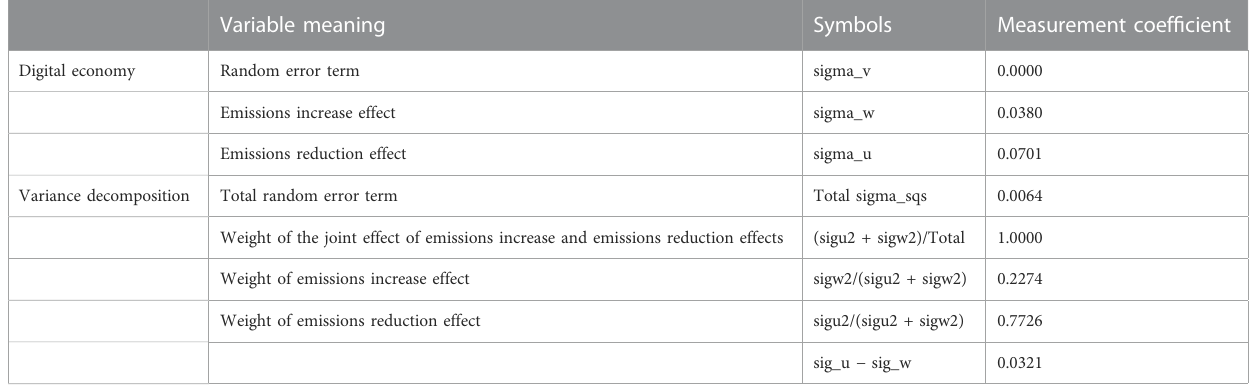
TABLE 9 Effect and variance decomposition of the impact of the digital economy on air